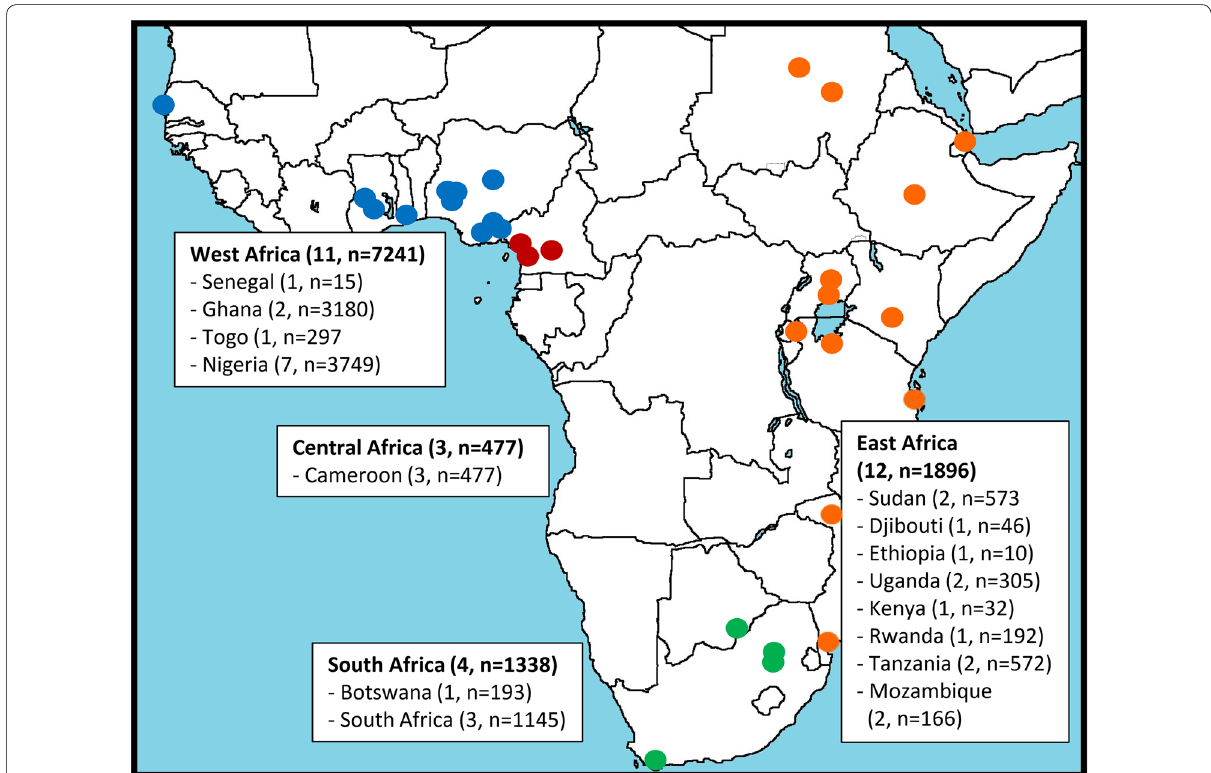
For prevalence and impact the numbers indicate the following levels: 1 low, 2 medium, 3 high. For difficulty, scoring is reversed with numbers indicating the = = = following levels: 1 high, 2 medium, and 3 low. This allows for a composite score where the higher numbers correspond to increasing relevance and applicability = = = of POCUS US ultrasound, TEE transesophageal echocardiography, cw continuous wave, b/w black and